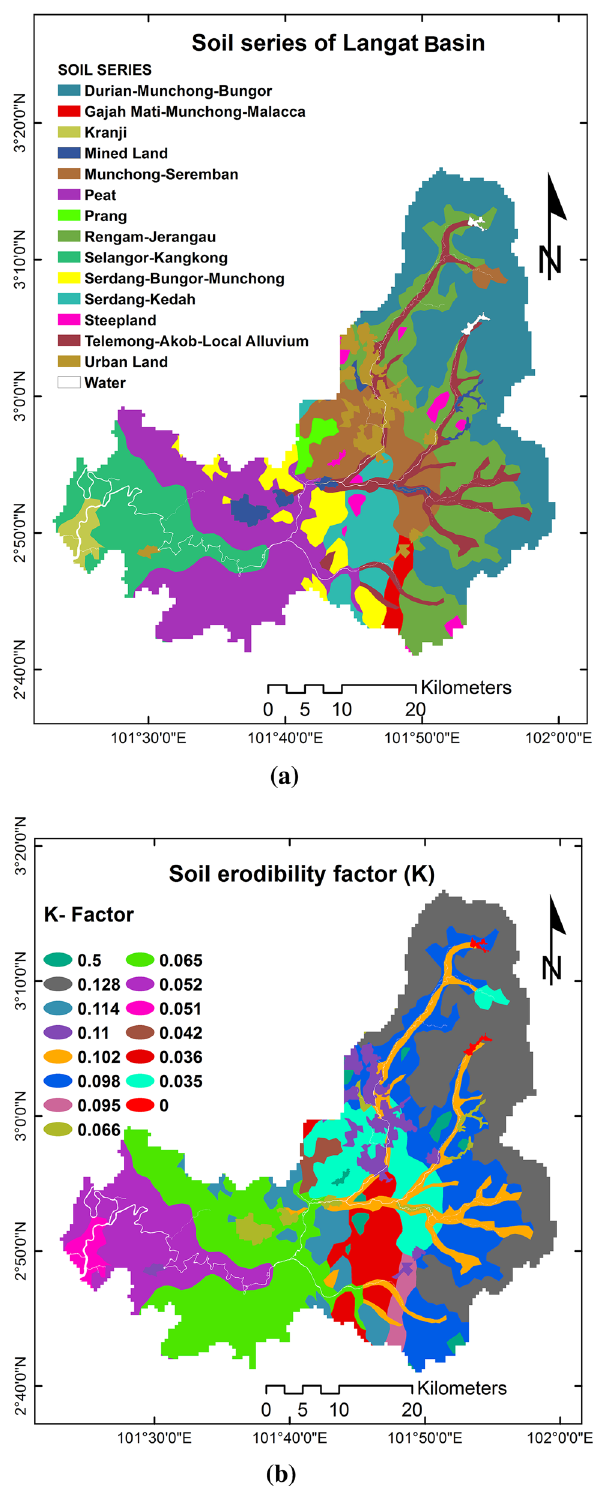
Fig. 5 Soil series ( a ) and soil erodibility factor (K) map ( b ) of the study